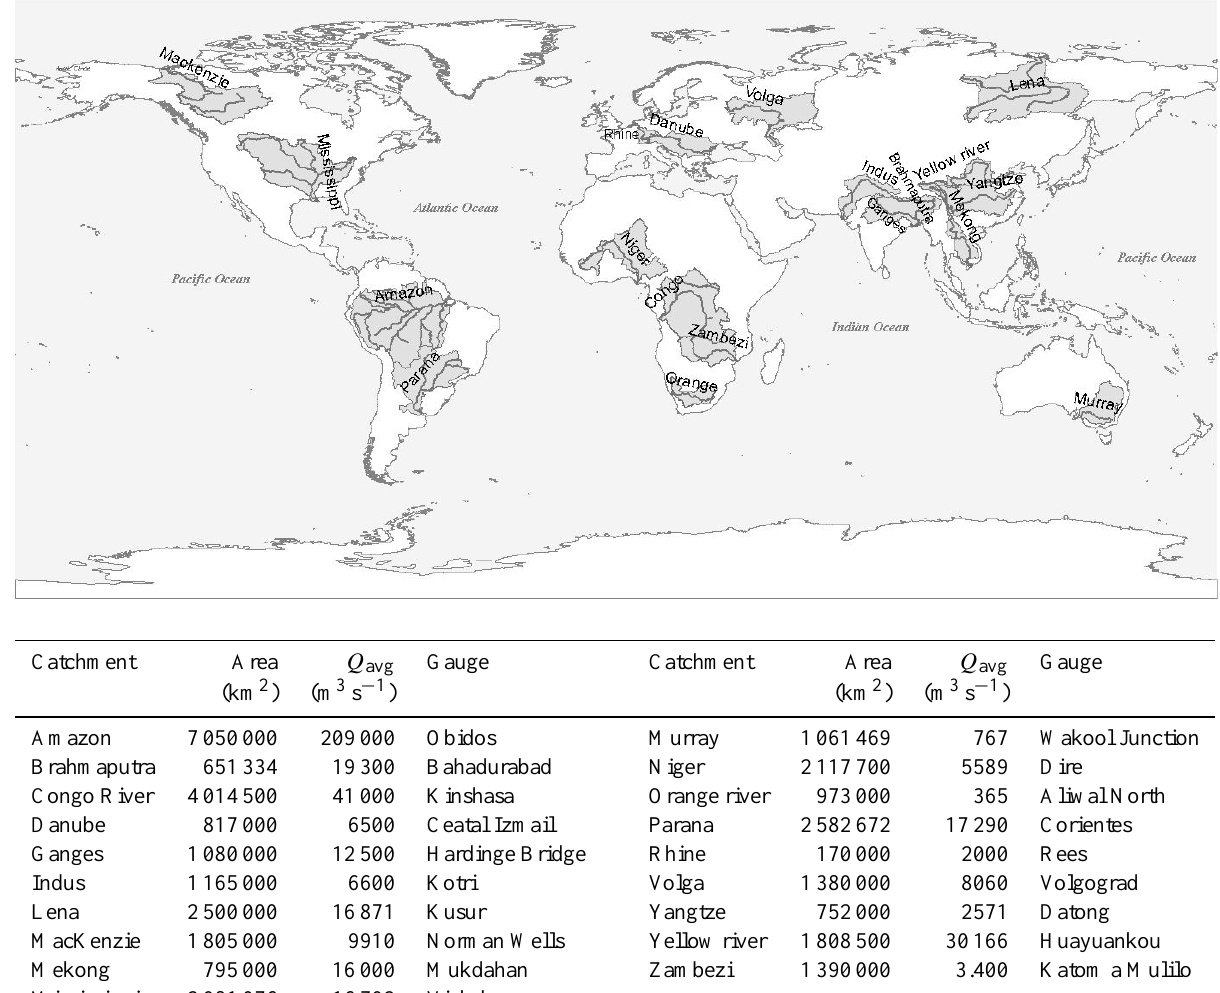
Fig. 1. Selected catchments with total catchment area, average observed discharge ( Q avg ; GRDC, 2007) and location of gauges for which statistics are calculated, annual cycles are given and comparisons are made.